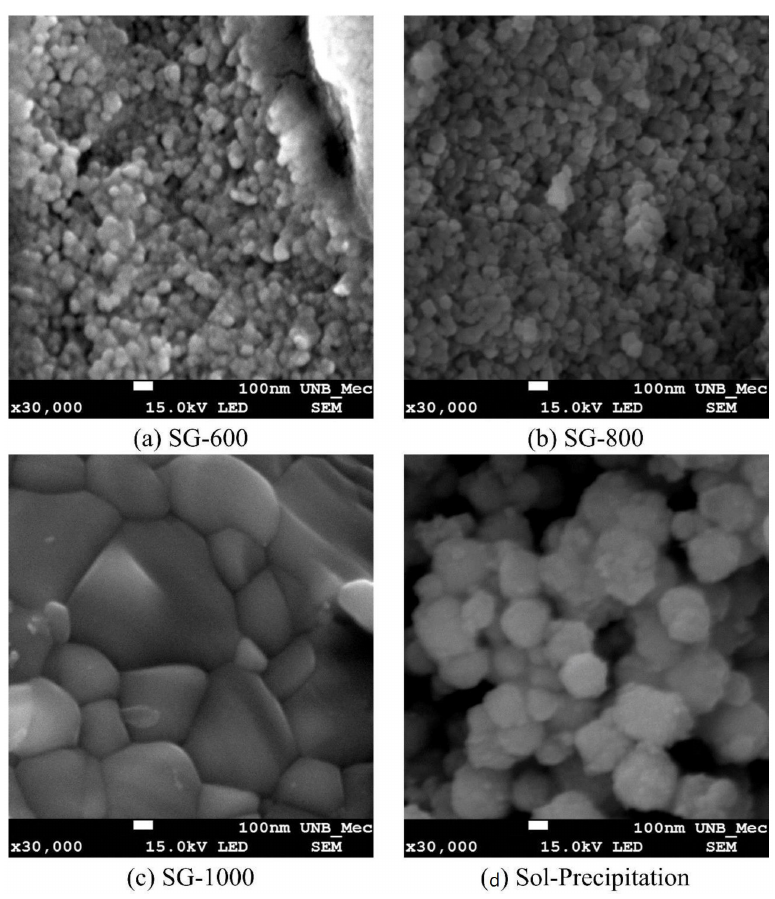
Figure 9. Scanning electron microscopy of powders synthesized by the sol-gel process at different temperatures: ( a ) 600 ◦ C, ( b ) 800 ◦ C, ( c ) 1000 ◦ C and ( d ) sol-precipitation. The micrographs also show an increase in the grain size of the ceramics with the calcination temperature. From an analysis of the images, it is concluded that the powder obtained by the sol-gel process and calcined at 600 ◦ C and 800 ◦ C has an average size between 60 and 80 nm, respectively, while the calcined powder at 1000 ◦ C consists of particles with an average size of 450 nm. The powders obtained by sol-precipitation had an estimated grain size of 220 nm. The graphs obtained from the UV-vis analysis of the powders synthesized by the sol-gel process at different temperatures (600 ◦ C, 800 ◦ C and 1000 ◦ C) and by the sol- precipitation process can be seen in Figure 10. The energy value of the forbidden band was estimated using the Wood–Tauc method.